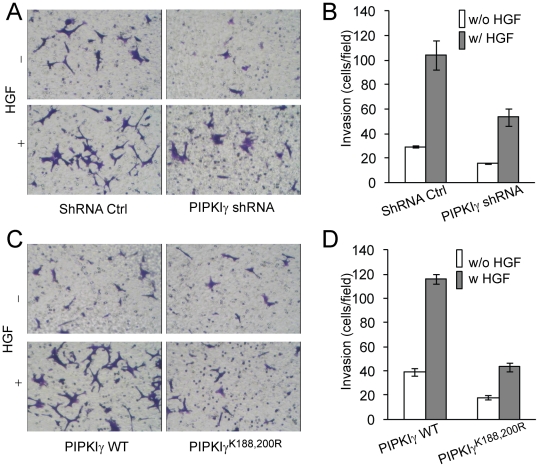
Either depletion of PIPKIγ or expression of PIPKIγK188,200R inhibited the invasion of HCT116 cells.(A) Depletion of PIPKIγ by using shRNA inhibited the invasion of HCT116 cells. The invasive capacities of cells stably expressing shRNA control or PIPKIγ shRNA were examined in the absence and presence of HGF (50 ng/ml) by Matrigel-based invasion assays. (B) Quantification of the invasion of HCT116 cells that stably express shRNA control or PIPKIγ shRNA. n = 5, error bar = mean ± s.e.m; ctrl vs PIPKIγ, p<0.01; ctrl HGF vs PIPKIγ HGF, p<0.01. (C) Expression of PIPKIγK188,200R inhibited the invasion of HCT116 cells. The cells that stably express EGFP-PIPKIγ or –PIPKIγK188,200R were tested for invasive capacities in the absence and presence of HGF. (D) Quantification of the invasion of HCT116 cells that stably express EGFP-PIPKIγ or –PIPKIγK188,200R. n = 3, error bar = mean ± s.e.m; WT vs K188,200R, P<0.01; WT HGF vs K188,200R HGF, P<0.005.